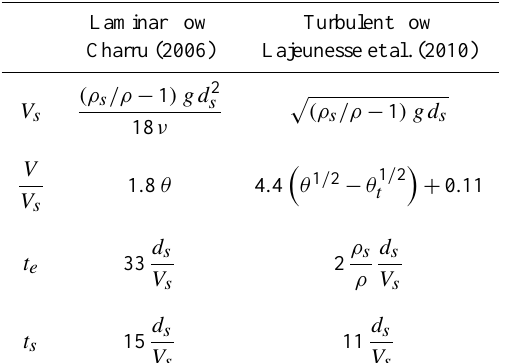
Table 1. Comparison of sediment transport characteristics for lam- inar and turbulent flows: particle settling velocity V s , mean stream- wise velocity of the particles V , erosion time t e , and settling time t s . Laminar flow Turbulent flow Charru (2006) Lajeunesse et al.